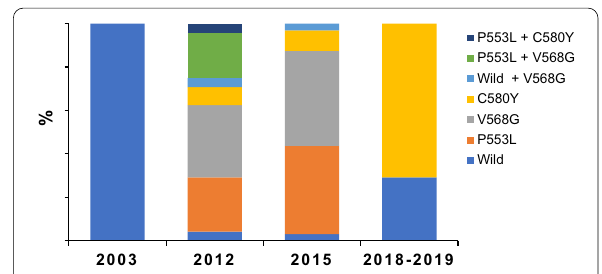
Fig. 2 Prevalence of Pfk13 mutations in Plasmodium falciparum in